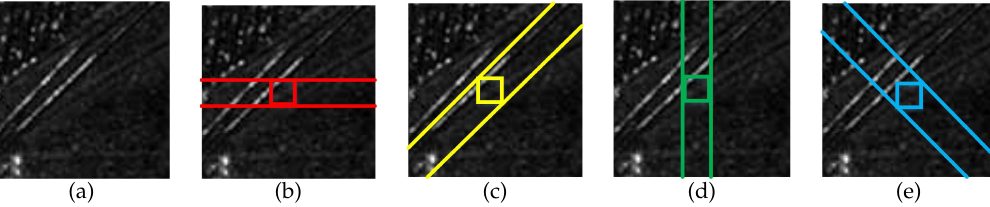
Figure 2. Four elemental directions are selected for edge extraction in an image patch. ( a ) image patch, ( b ) 0 ◦ , ( c ) 45 ◦ , ( d ) 90 ◦ , and ( e ) 135 ◦